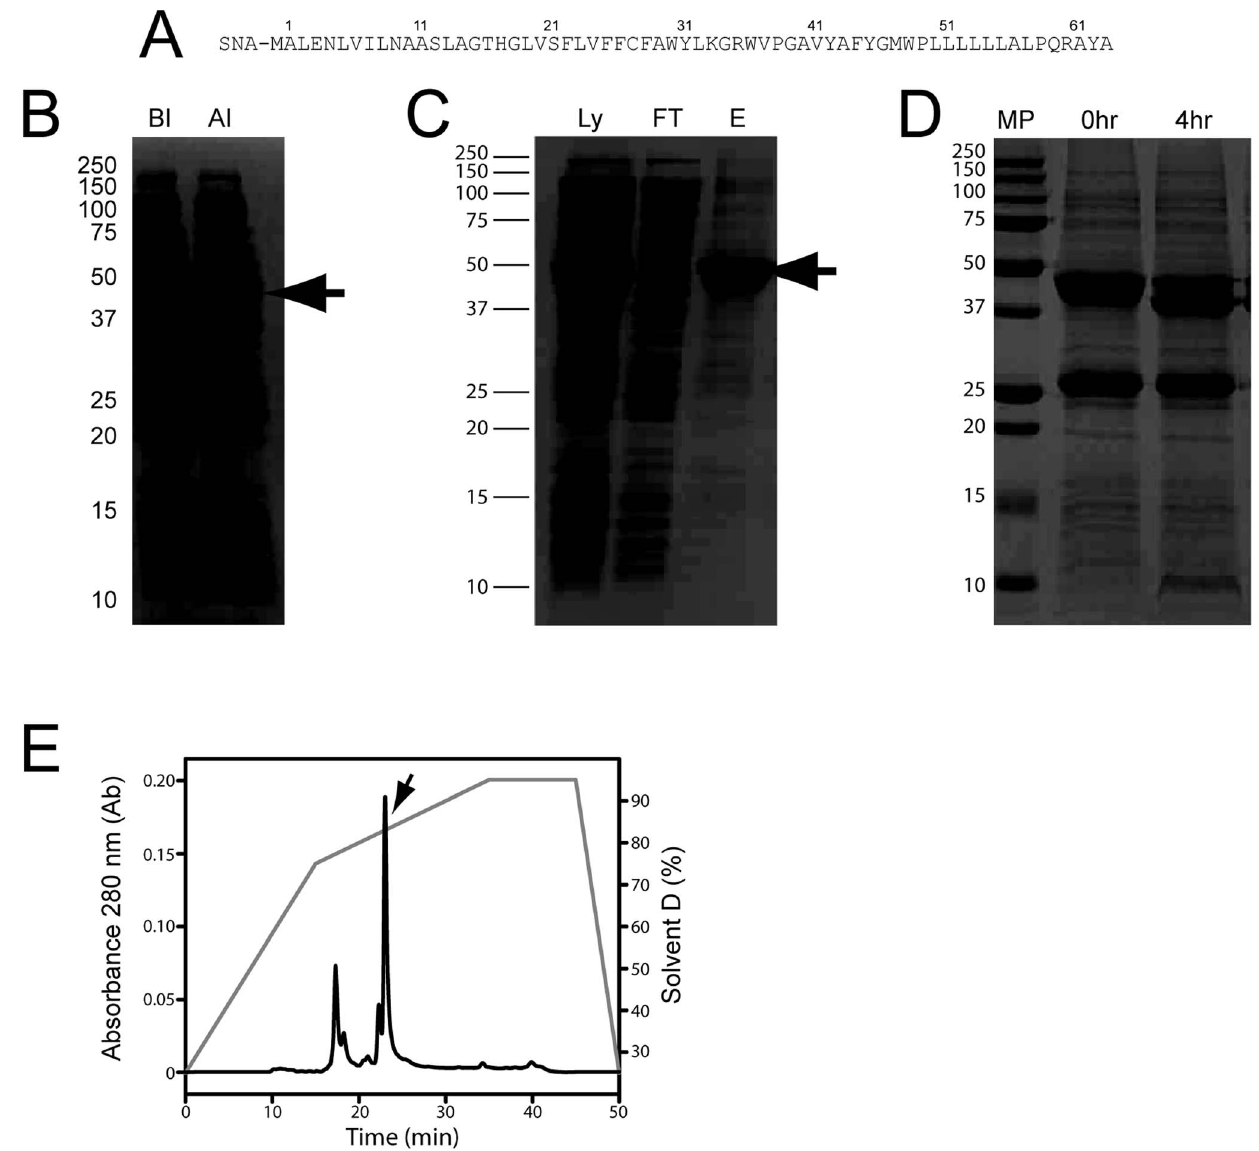
after IPTG induction which corresponds to MBP-p7 fusion protein (arrow). BI, before IPTG induction; AI, 16 hours after IPTG induction; (C) Ni 2 + -NTA purification of MBP-p7 with close to 85% purity after elution in 500 mM imidazole. Ly, supernatant of total cell lysate; FT, flow through from Ni 2 + -NTA column; E, eluent from Ni 2 + -NTA column (D) TEV digestion results of MBP-p7 at room temperature, at time 0 and after 4 h incubation with gentle shaking; (E) RP-HPLC purification of p7 with a C3 RP-HPLC chromatography column. The peak corresponding to purified p7 is indicated by an